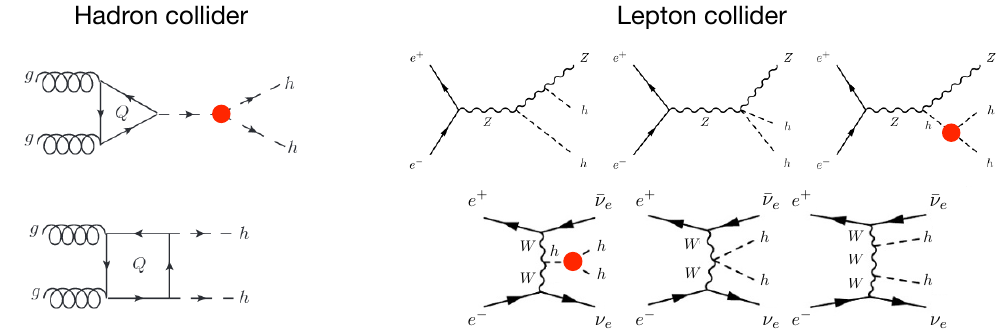
Figure 9 . Representative Feynman diagrams for the leading contribution to double Higgs produc- tion at hadron (left) and lepton (right) colliders. Extracting the value of the Higgs self-coupling, in red, requires a knowledge of the other Higgs couplings that also contribute to the same process. See table 18 for the SM rates. At lepton colliders, double Higgs production can also occur via vector boson fusion with neutral currents but the rate is about ten times smaller. The contribu- tion proportional to the cubic Higgs self-coupling involves an extra Higgs propagator that dies o(cid:11) at high energy. Therefore, the kinematic region close to threshold is more sensitive to the Higgs self-coupling.